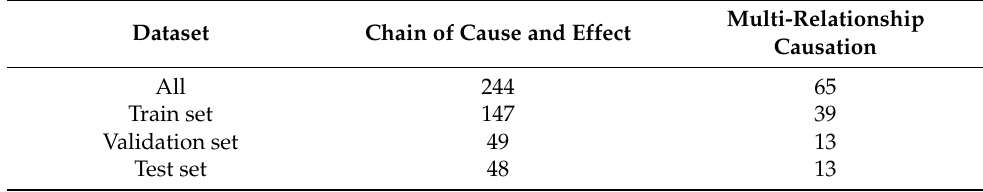
Table 3. Complex causal